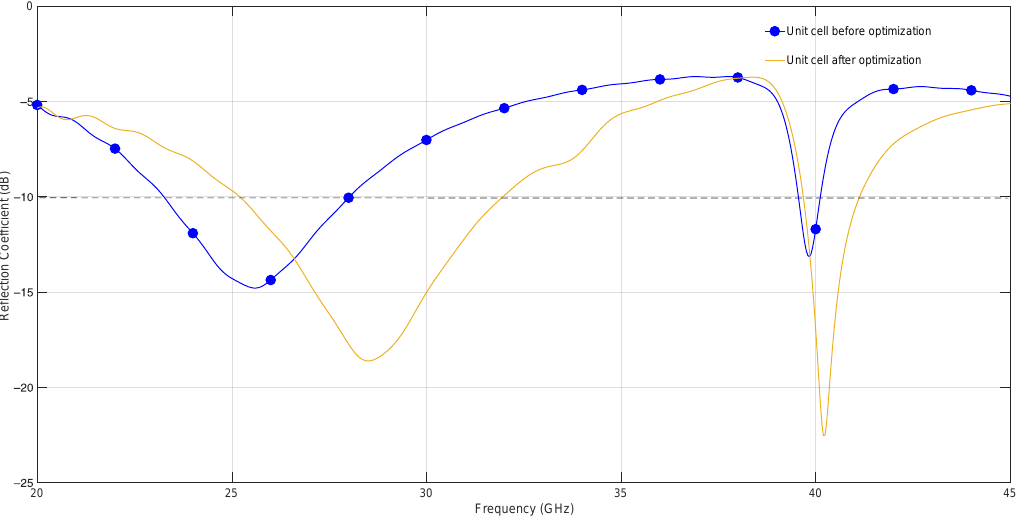
Figure 6. Return loss results of metasurface unit cell before and after optimization.